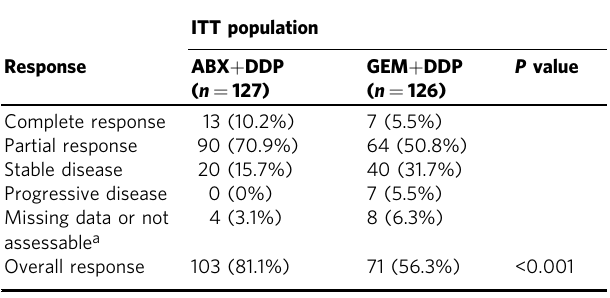
Table 2 Locally assessed response to study treatment in ITT